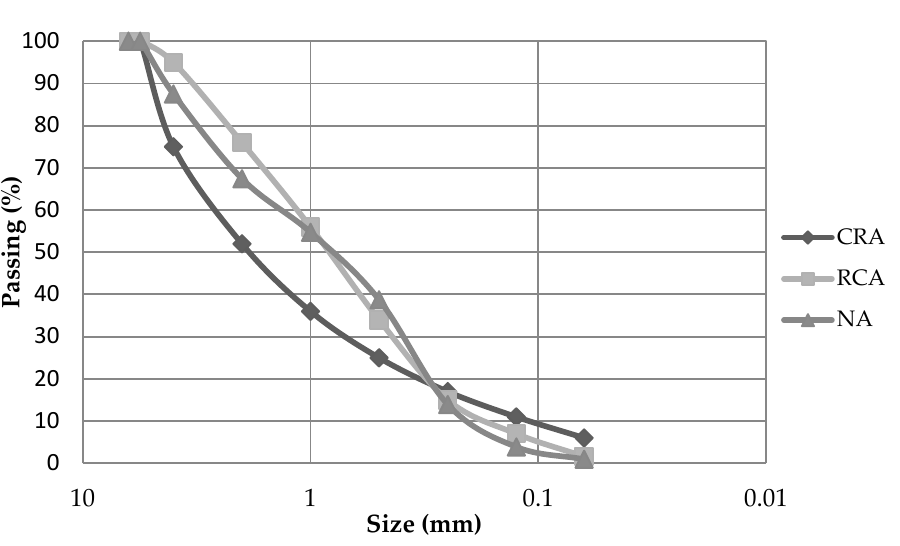
Figure 1. Particle size distribution for ceramic recycled aggregate (CRA), recycled concrete aggregate (RCA) and natural aggregate (NA) samples.